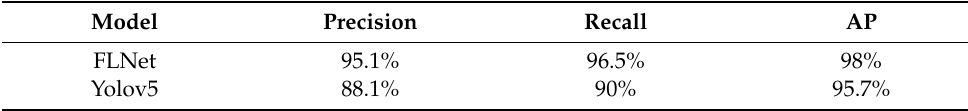
Table 2. Experimental results on SSDD